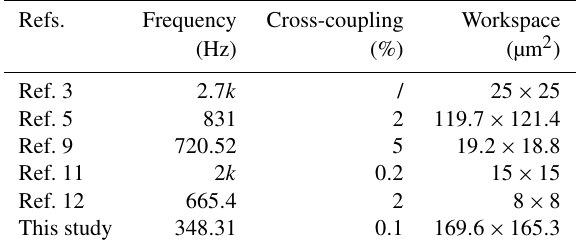
Table 4. Property comparisons for proposed xy stages.